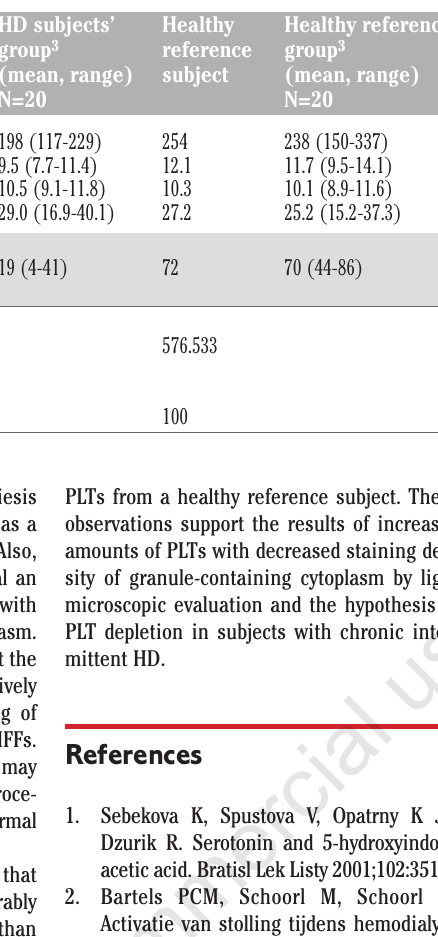
Table 1. Laboratory, light microscopic and EM data from a HD subject and healthy ref- erence subject. For comparison data of the groups of 20 chronic HD subjects and 20 healthy reference subjects are used.